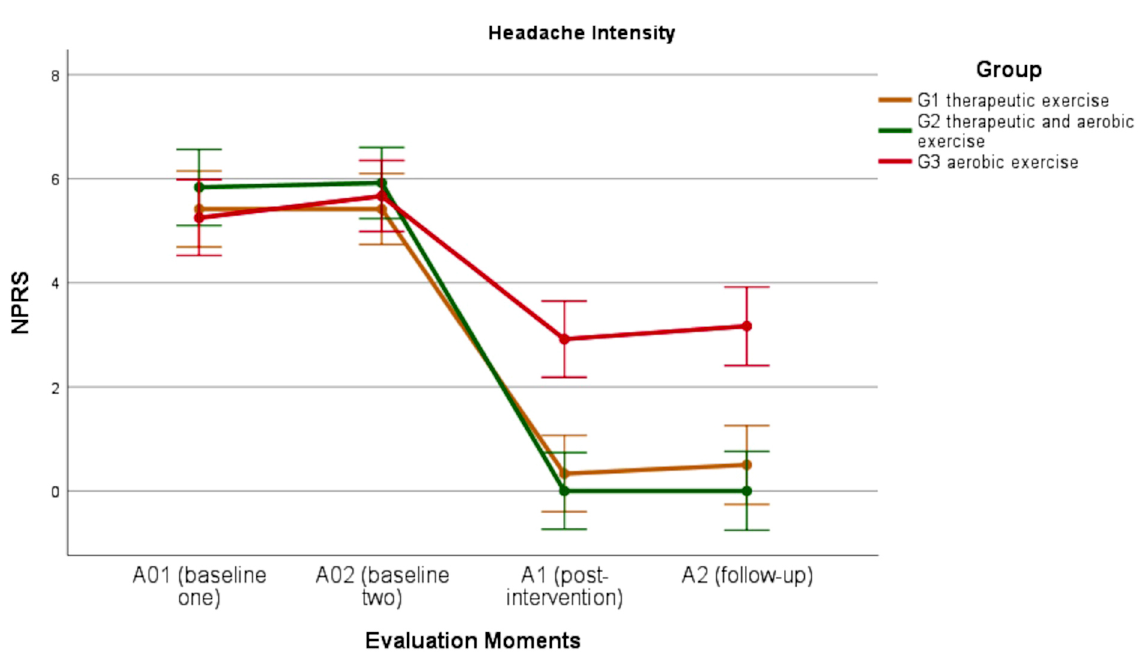
Figure 2- Changes in headache intensity at the different times points (NPRS – numeric pain rating